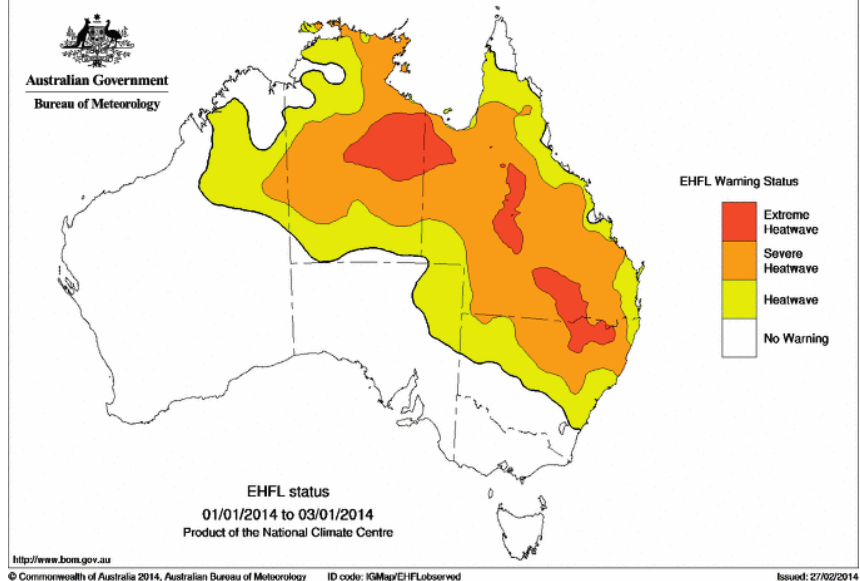
, thereby indicating 85